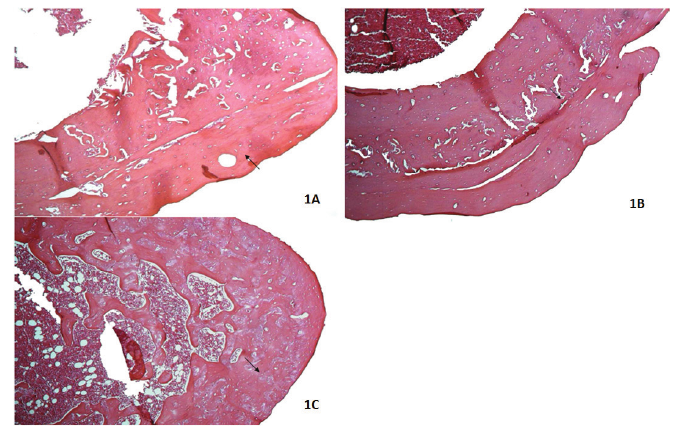
FIGURE 3 - Light microscopy findings at 120 days postoperatively, approximately 100x magnification, hematoxylin and eosin (HE) stain.